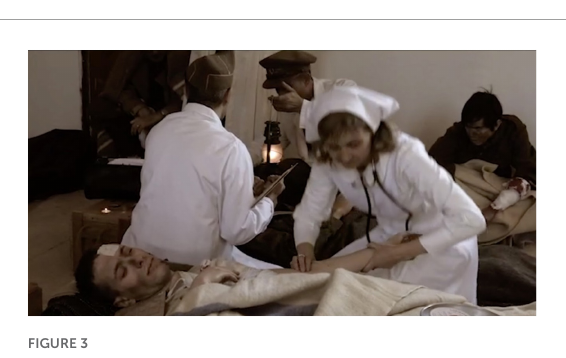
FIGURE3 Students of master’s studies in cultural and